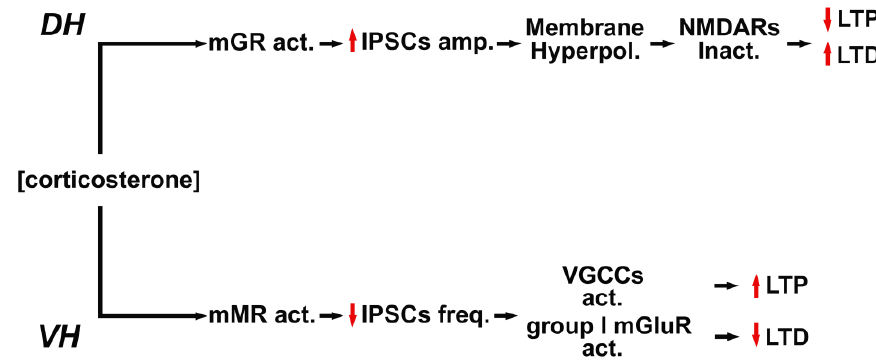
FIGURE 2. Proposed mechanism by which MR and GR differently regulate LTP and LTD in the DH and VH. In the DH, mGR activation increases IPSC amplitude. This results in a hyperpolarization of the pyramidal cell membrane and inactivation of NMDA receptors, therefore impairing LTP and enhancing LTD. In the VH, mMR activation reduces IPSC frequency. This determines an increase in the excitability of the pyramidal cells and raises the possibility of VGCC activation, thus enhancing LTP. In addition, a decrease in GABAergic inhibition can impair LTD through a group I mGluR-mediated